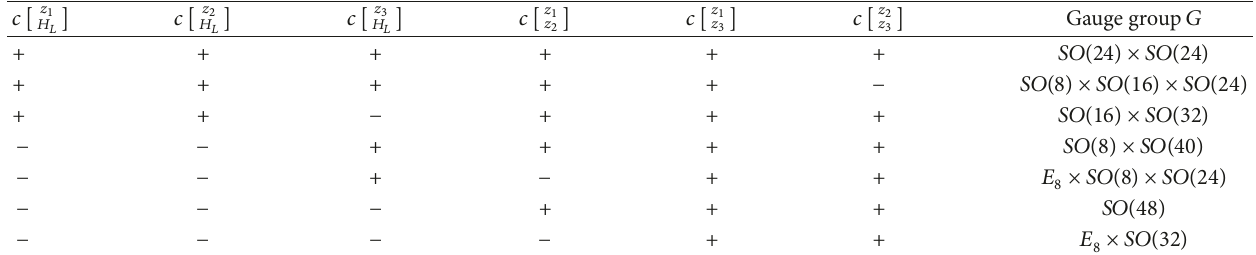
Table 2: The configuration of the symmetry group with five basis vectors.